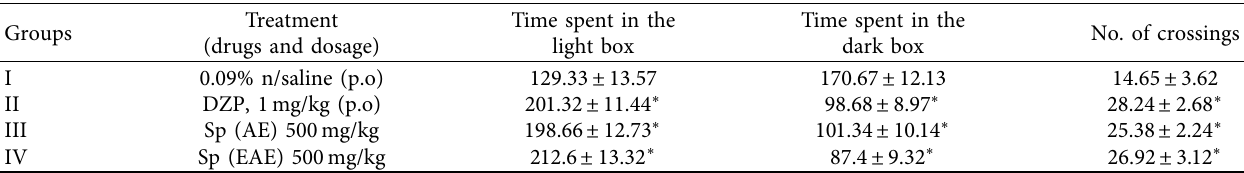
Figure 3: Antidepressant-like efcacy of treatment with Sp extracts in depressive behavior in response to FST. Immobility (a) and swimming (b) were recorded during FST. Columns show the means ± SD ( n � 6). Table 4: Efect of Sp extracts on the light and dark